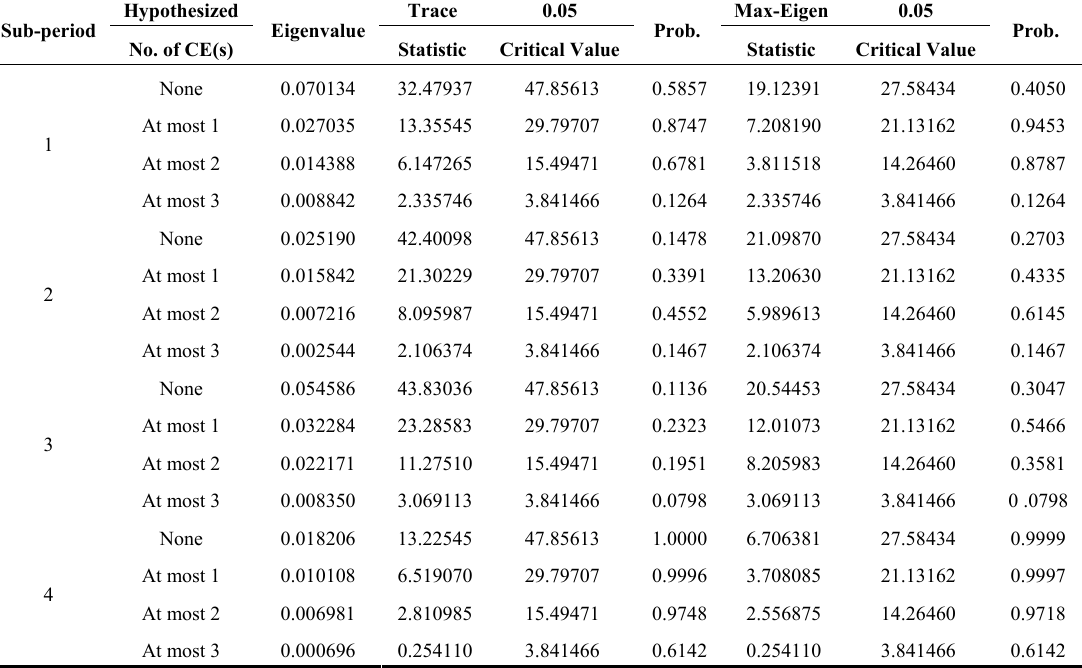
Table A15. Test for Possible Regional Cointegration in